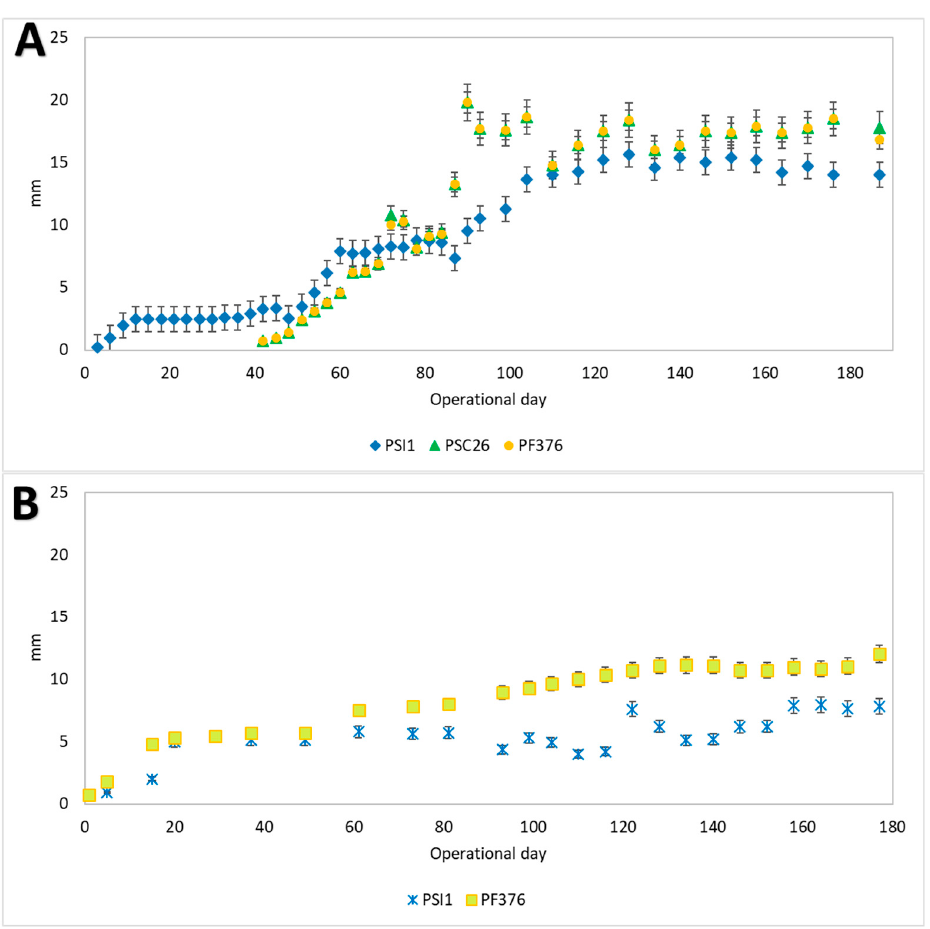
Figure 2. Mean size of granular biomass of Pseudomonas fluorescens PSC26 (PSC26), Pseudomonas fluorescens 376 (PF376), and Pseudomonas stutzeri I1 (PSI1) fed with sodium acetate ( A ) and methanol ( B ).